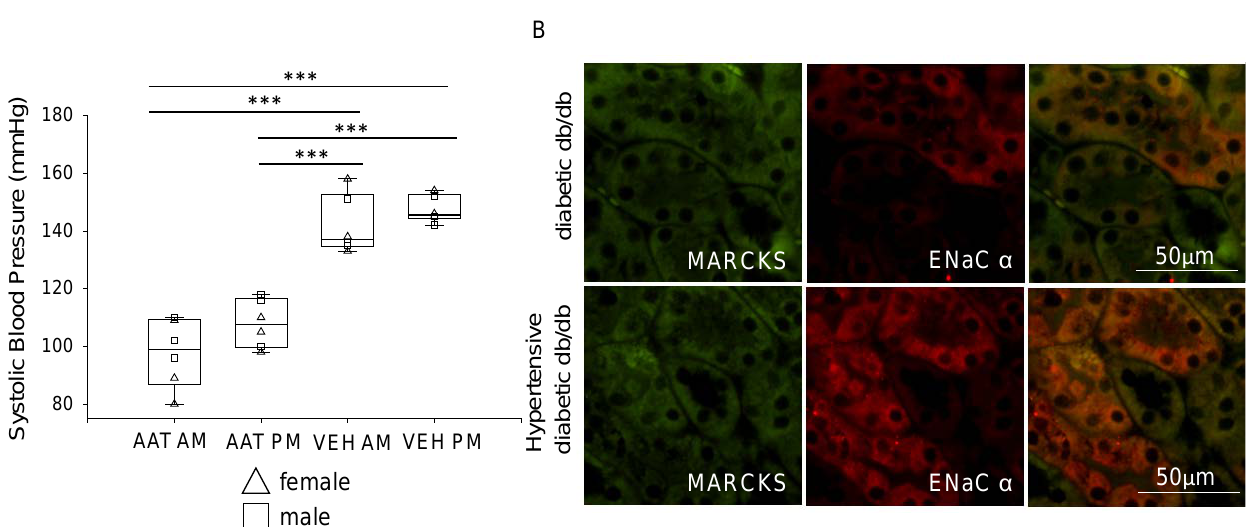
Figure 3. Changes in systolic blood pressure in hypertensive diabetic db/db mice after treatment with vehicle or hAAT. ( A ). Tail cuff systolic blood pressure measurements during the inactive (AM) and active (PM) cycles for female and male hypertensive diabetic db/db mice treated with hAAT and hypertensive diabetic db/db mice given vehicle in which both groups were maintained on a high salt (HS) diet. N = 6 hAAT treated (3 females and 3 males) and N = 6 VEH (3 females and 3 males) mice. These results were analyzed using a One-Way ANOVA followed by a Holm–Sidak comparison. *** represents a p < 0.001. ( B ). Representative immunohistochemistry images of MARCKS and ENaC alpha proteins in non-salt loaded diabetic db/db mice and salt-loaded hypertensive diabetic db/db mice (N = 6 mice in each group).